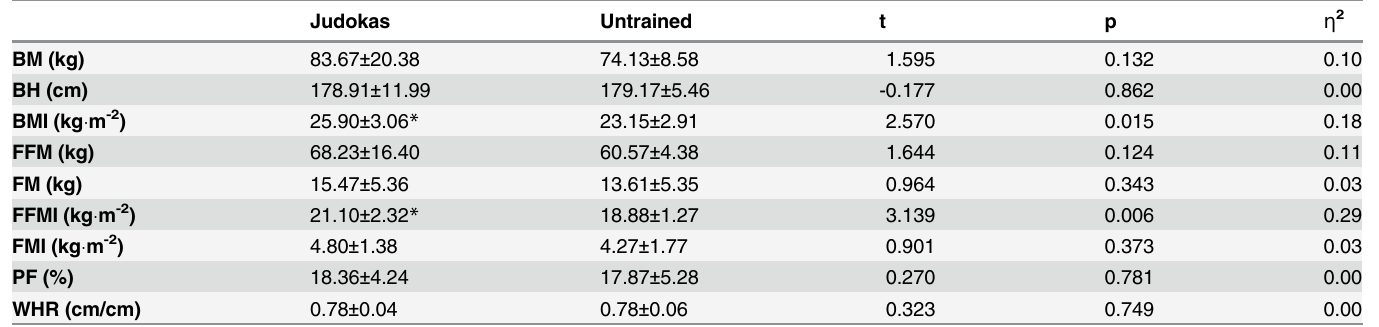
Table 3. Body build and body composition of study participants (mean, SD, t, p, ƞ 2 ). Judokas